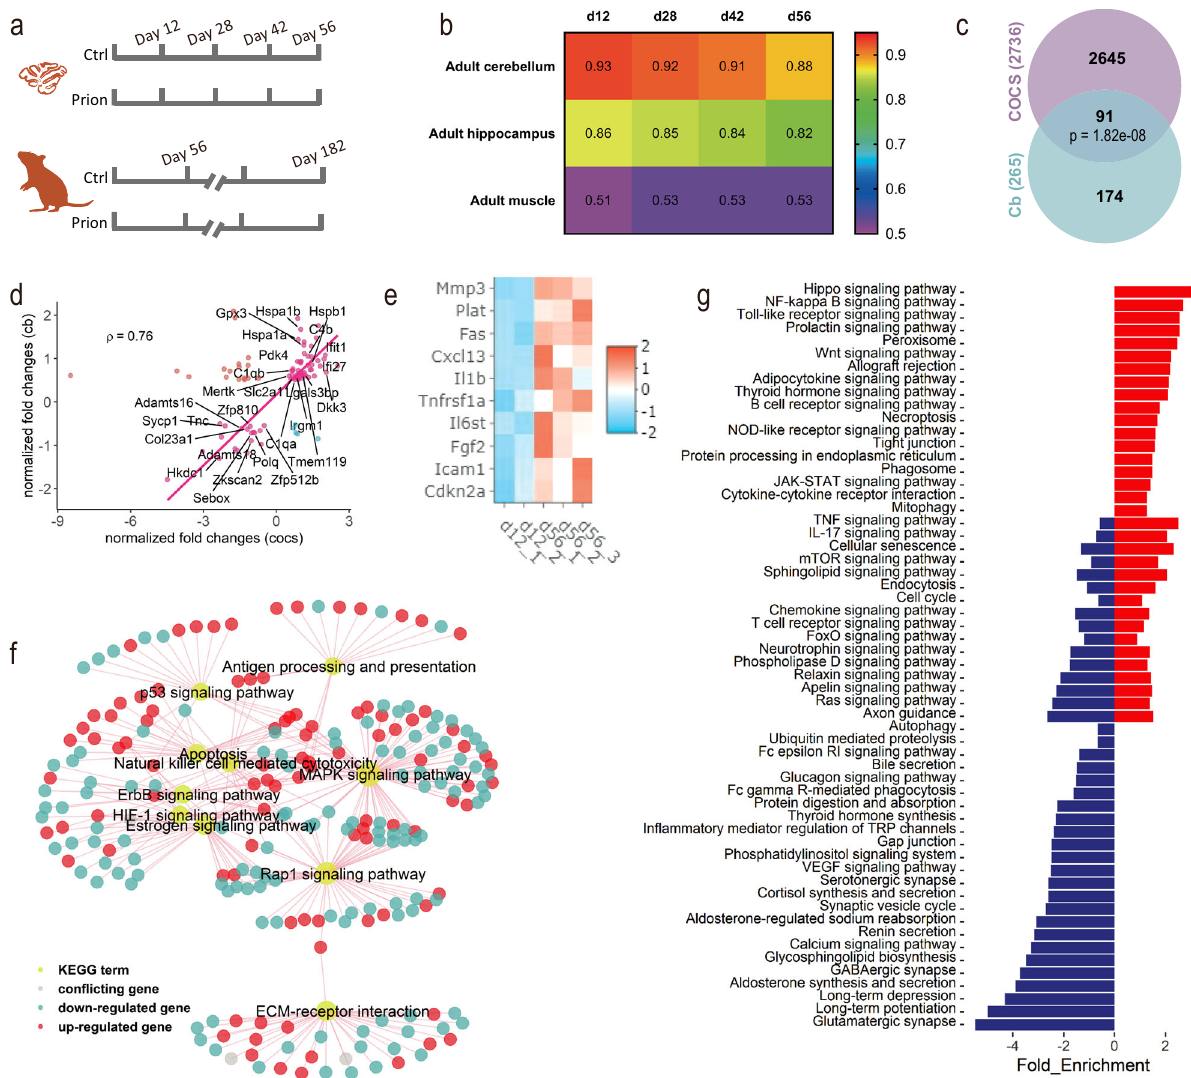
Fig. 1 COCS recapitulate in vivo gene expression and undergo rapid aging. a Design of the RNAseq experiments. b Spearman ’ s correlation coef fi cient ( ρ ) of gene expression in COCS (12-56 days) with adult mouse cerebellum, hippocampus and muscle. X -axis indicates days ex vivo of COCS. c Overlap between DEG of aged COCS and cerebellum (p: hypergeometric test). d Changes of common DEG in aged COCS vs cerebella. Genes of interest are highlighted with their names. Genes show different directions of changes in the two conditions are highlighted in cyan or red. e Heatmap showing the expression of cellular senescence genes, including p16 (Cdkn2a) and members of the senescence-associated secretory phenotype, in young (12 days) and old (56 days) COCS. f Subset of common KEGG pathways that are signi fi cantly (FDR < 0.05) dysregulated in aged COCS and cerebellum. g Additional KEGG pathways that are signi fi cantly (FDR < 0.05) enriched in the DEG of aged COCS. Negative and positive values of the x -axis indicate downregulation and upregulation during aging, respectively. Blue bars: downregulated pathways in aged COCS. Red bars: upregulated pathways in aged